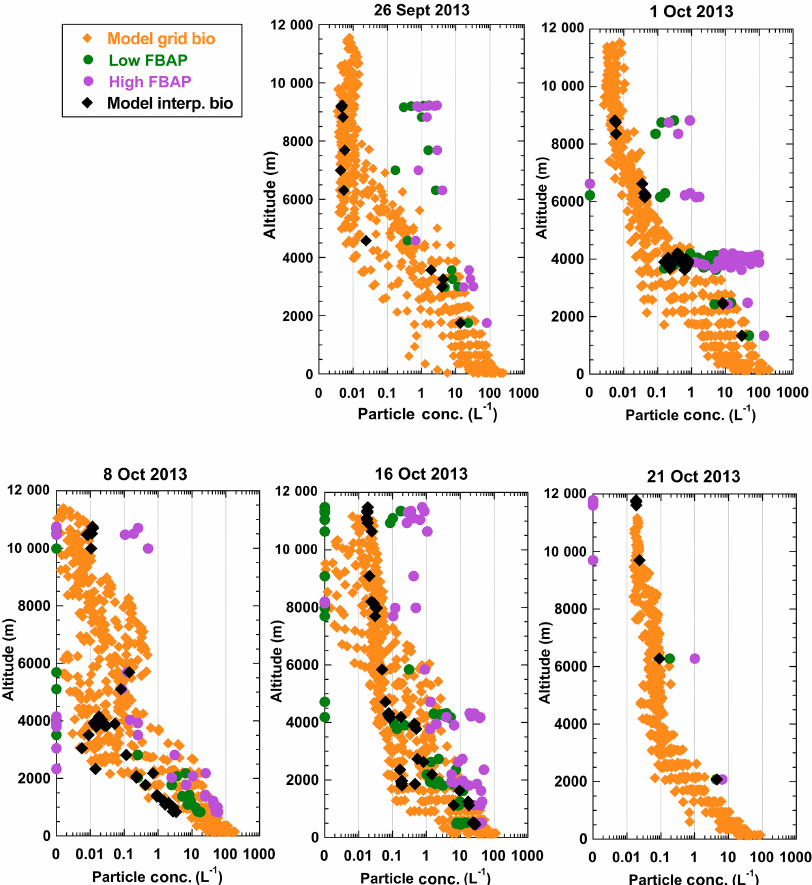
Figure 7. Model-predicted biological particle concentration (L − 1 ) as a function of altitude above ground for the five flights. Orange diamonds are all points in 25 grid boxes within the IDEAS domain (latitude range 37.30–46.63 ◦ N, longitude 107.81–98.44 ◦ W) for 18:00UTC on each day. Black diamonds are model data interpolated to altitude, horizontal location, and time of the measurements. Green and magenta circles are the low and high FBAP values from the WIBS-4A data, as described earlier and shown in Figs. 4 and 5. Zero values are set to 0.001 so they are visible on the log